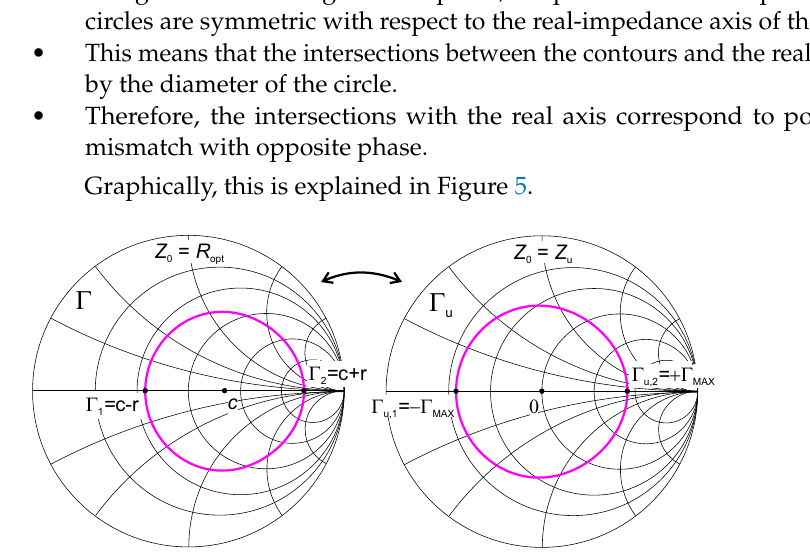
Figure 5. Graphical explanation of the method used to achieve the equivalent mismatch